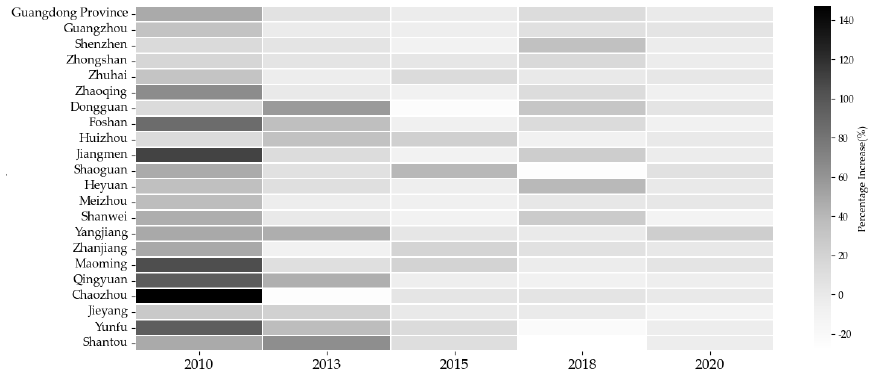
Figure 4. Percentage increase of GHG emissions. Note: the percentage increase is based on the last recorded year. For example, the increment rate of 2010 is based on 2005, et cetera.